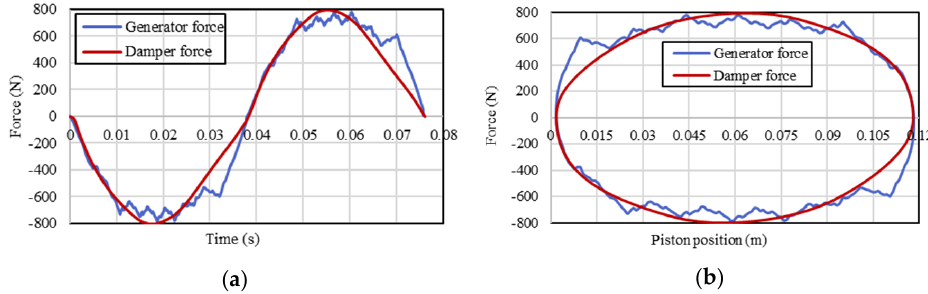
Figure 13. Linear generator reacting force Model ‘A’: vs. ( a ) time and ( b ) piston position. With the coupled model of the LEG, the linear engine is connected to the generator, which is in an open circuit condition to look at the ripple force of the generator. This ripple force, i.e., the cogging force, is due to the non-uniformity of the reluctance path in the air gap area (slot effects) and oversizing of the translator or stator (end effects), as well as the velocity effect/core loss (iron loss and eddy current loss). The cogging force of the Model ‘A’ generator versus time and piston position can be seen in Figure 14.